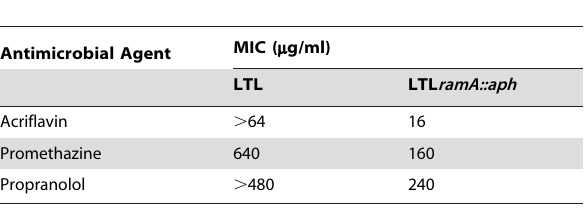
Table 3. Antimicrobial activities of acriflavin, promethazine, and propranolol against S . Typhimurium strain LTL and its ramA